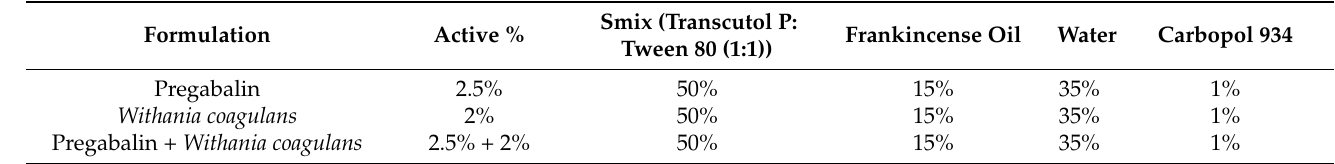
Table 1. Composition of pregabalin and Withania coagulans topical gel includes frankincense oil, Transcutol P: Tween 80 (1:1), and